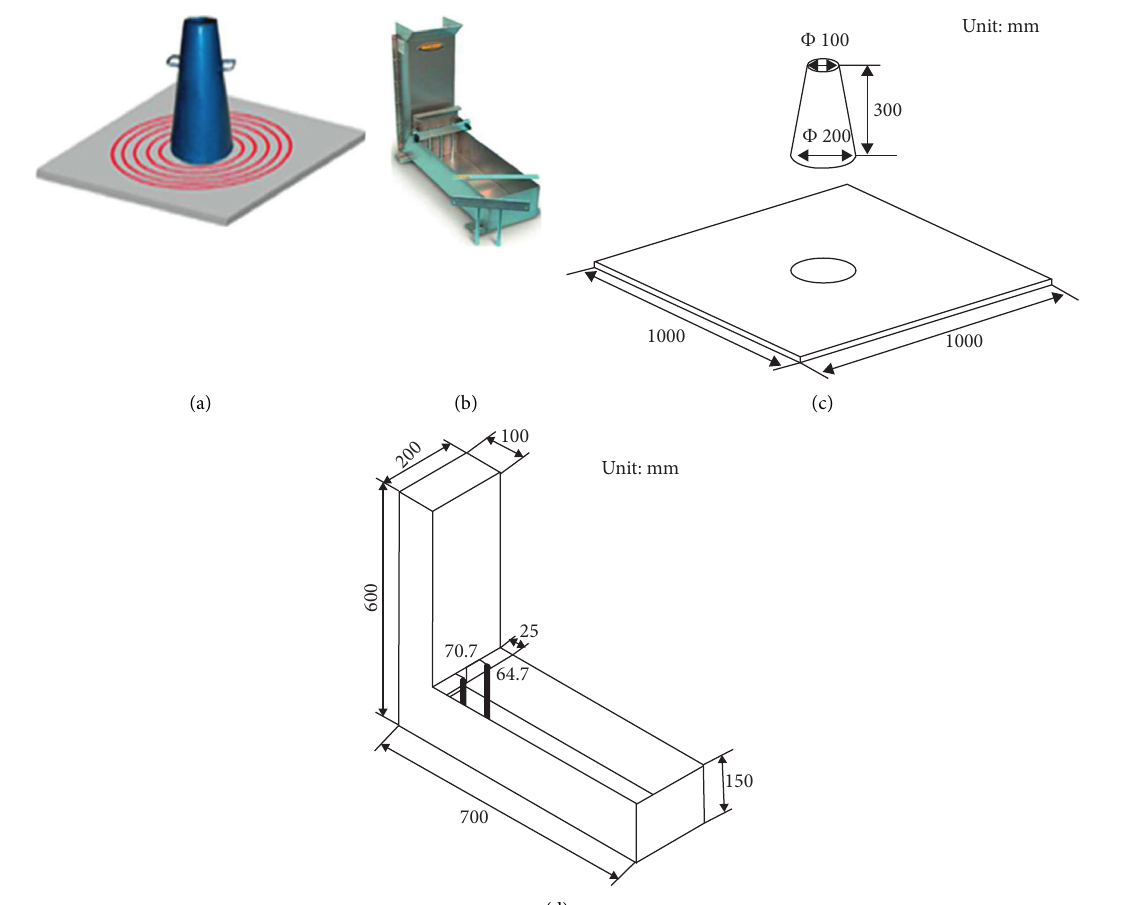
Figure 3: The fresh concrete in experiments (a) and simulations (b).